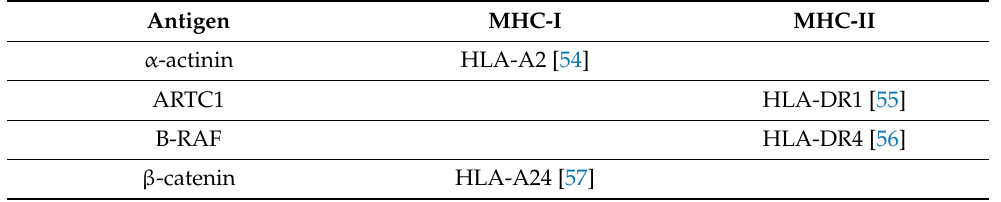
Table 1. Tumor antigens arising from mutations.